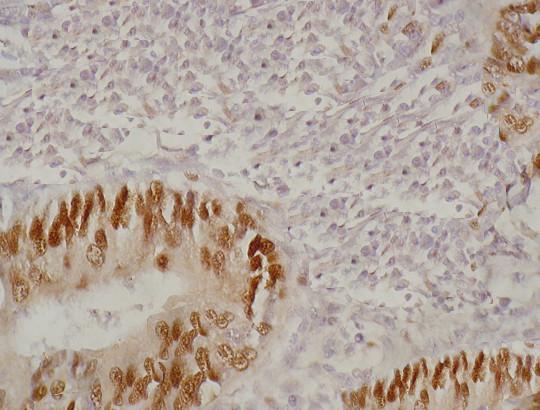
Immunohistochemical staining of c-fos expression in the lung adenocarcinoma tissues. c-fos showed nuclear staining pattern.